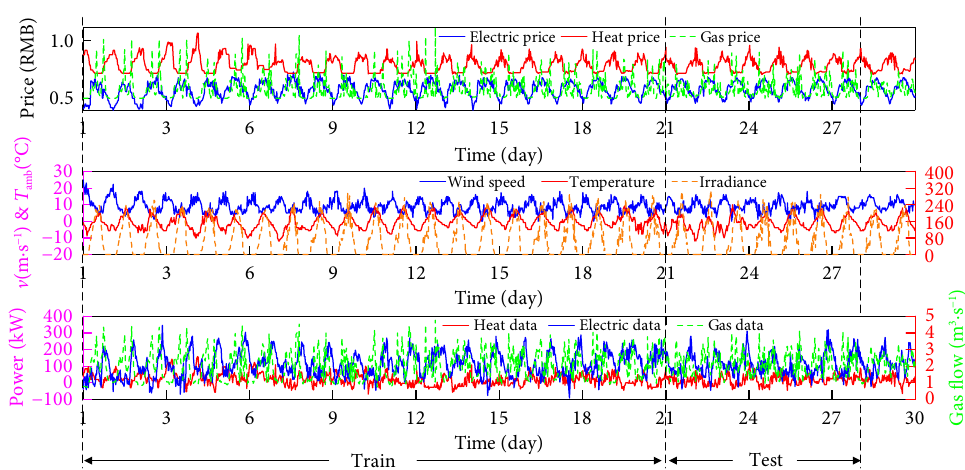
Fig. 8 One month’s operating data for experiments.